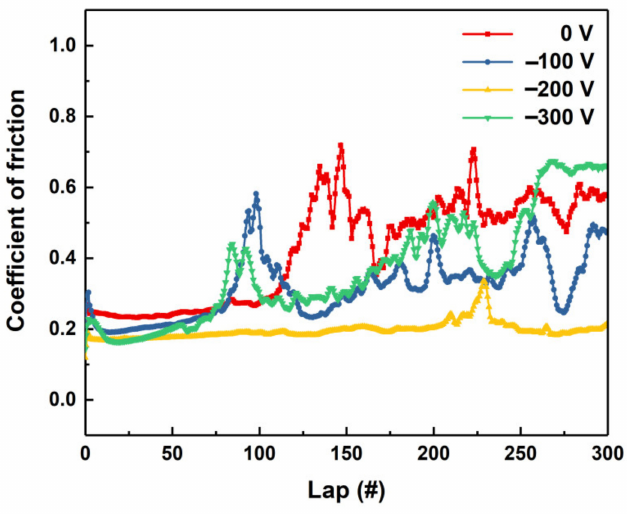
Figure 7. Dynamic curves of the friction coefficients of the TaN x coatings deposited with various bias voltages as a function of test